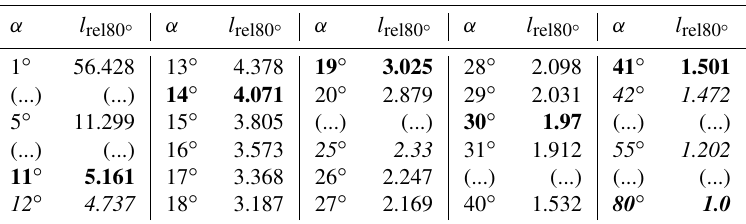
Figure A2. Simulated TBs at frequency channels between 50 and 60GHz at different flight altitudes (different line styles) for a horizontal viewing angle (a) and a near-zenith angle (b) . Solid vertical lines: standard frequency channels of the MTP; dashed vertical lines: strong lines that could be used as new MTP LOs. Shading around vertical lines: MTP filter width. Lines corresponding to altitudes of 8km or lower overlap in panel (a) . Table A1. Signal path lengths relative to ± 80 ◦ . Values in italic font: elevation angles used in the standard measurement strategy. Values in bold font: possible candidates for a new strategy. Elevations in between, which are marked by (...), do not correlate with integer values in relative path lengths.